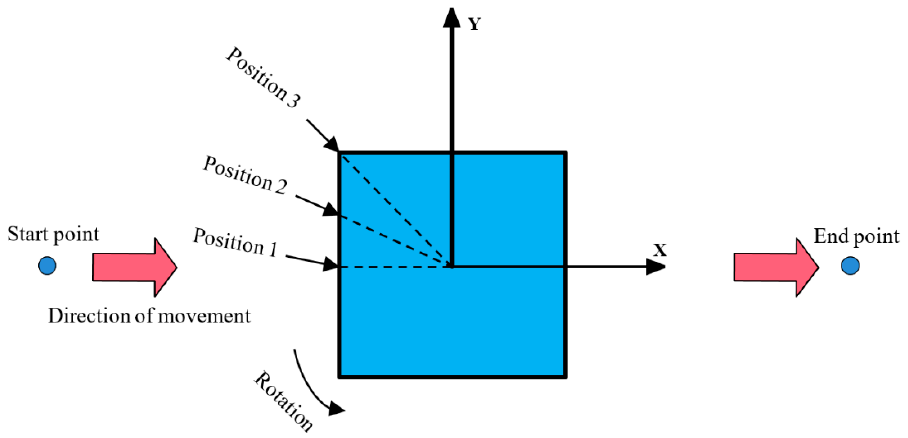
Figure 10. Schematic diagram of the movement orientation of the detection device and its relative